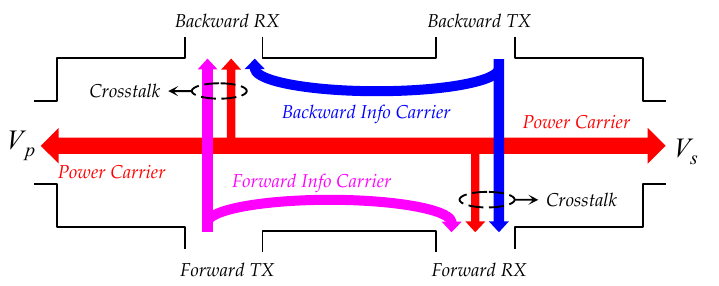
Figure 7. Six-port network of the wireless information and power transfer system.